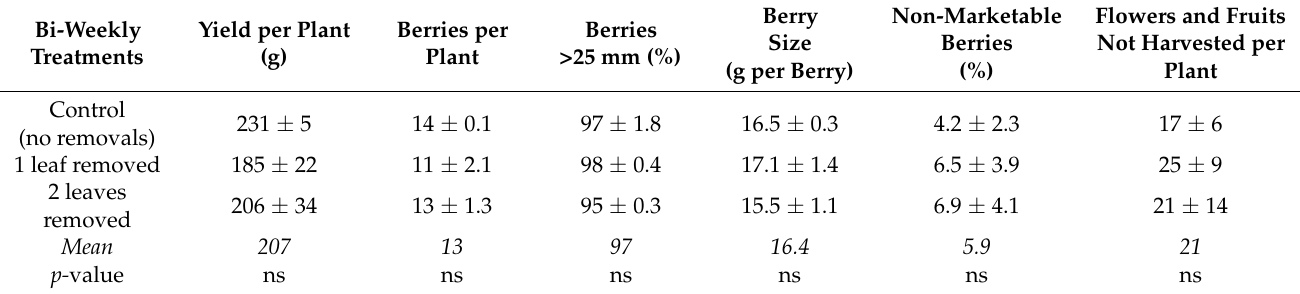
Table 2. Effects of bi-weekly runner removal and leaf thinning in the period 5 June to 25 September on runner yield performance (berries harvested from 5 July to 7 October) of the everbearing strawberry cv. ‘Favori’. The data are means ( ± SD) of three replicates with six plants